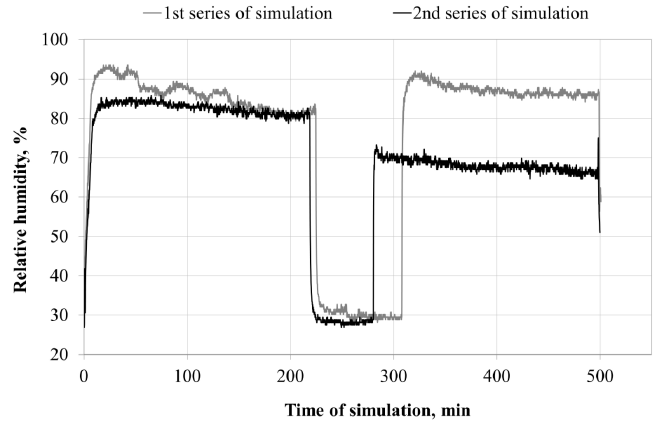
Figure 3. Changes in relative humidity inside the FFR during simulated breathing cycles.